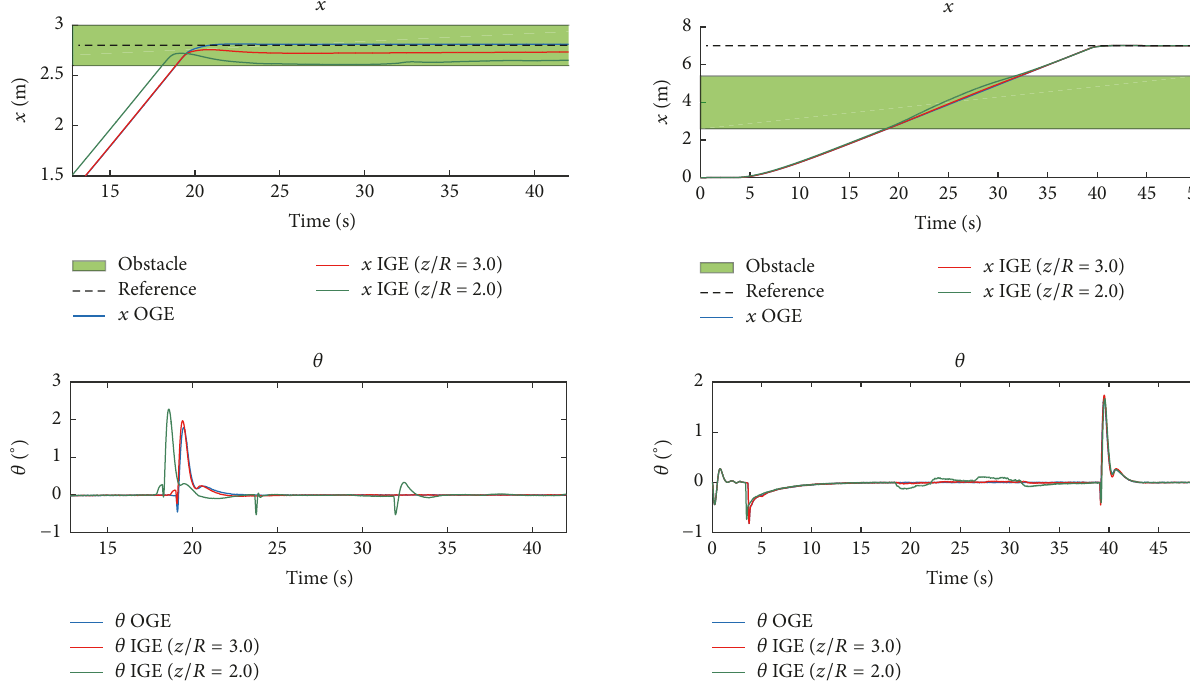
Figure 18: Estimated torque controller: hovering in partial ground effect.